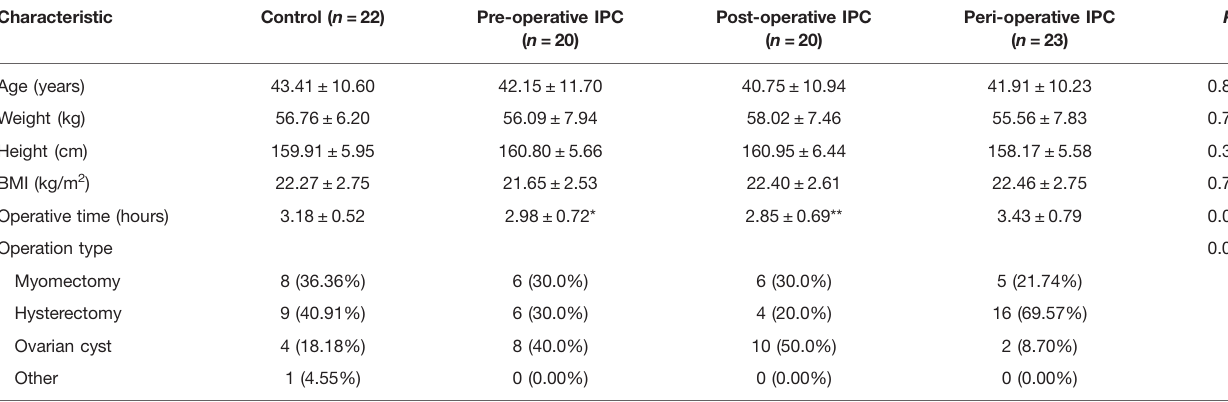
TABLE 1 | Clinical characteristics of the